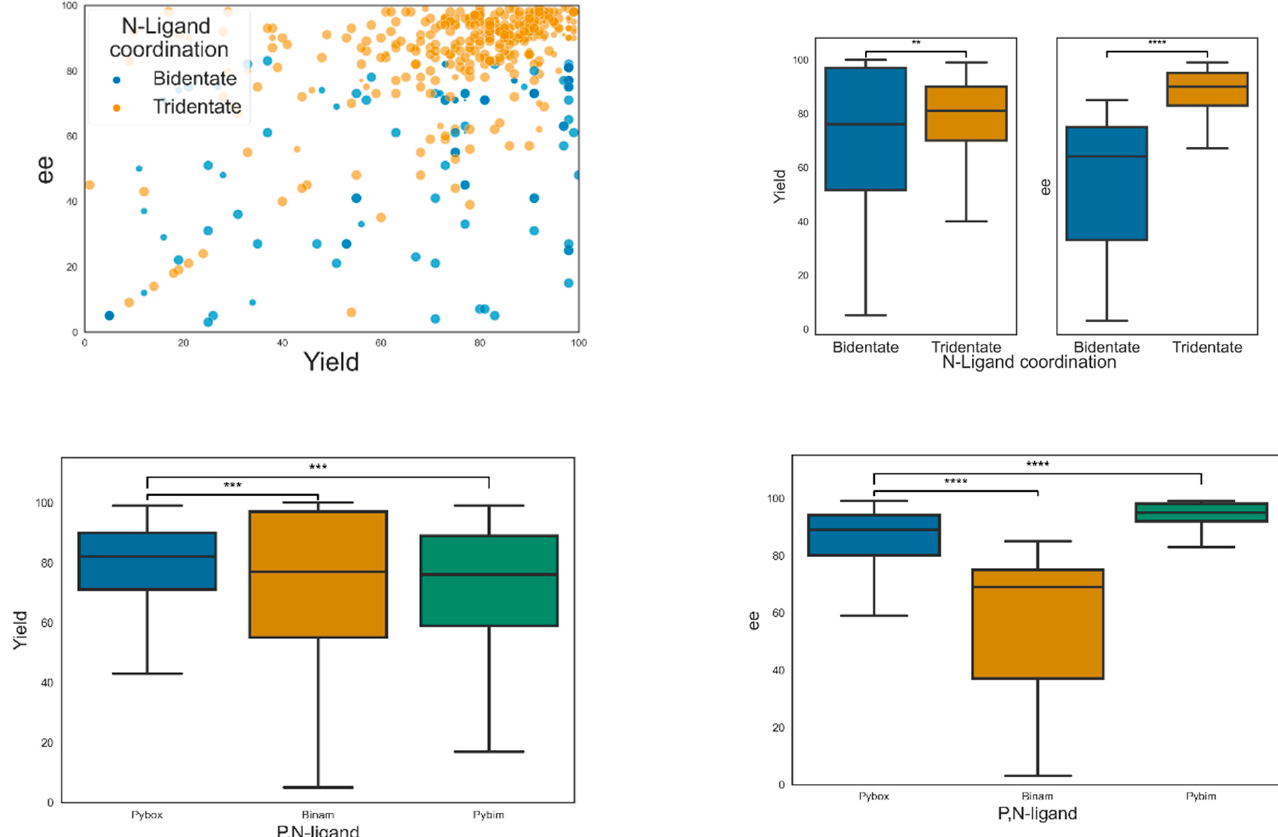
Figure 11. ( upper ) Distribution of N-homoligands by coordination. ( left ) Comparison of yield and ee for N-homoligands. Significance calculated using Student’s t -test ( p = 0.004, 1.74 × 10 − 39 ) ( right ). ( Lower ) Comparison of yield N-homoligands with secondary coordination sphere, the significance was calculated using Student’s t -test ( p = 0.0074, 0.0011) ( left ) Comparison of ee N-homoligands with secondary coordination sphere. Significance calculated using Student’s t -test ( p = 1.55 × 10 − 27 , 0.00015) ( right ). Symbol Meaning: ** p ≤ 0.01, *** p ≤ 0.001, **** p ≤ 0.0001 (For the last two choices only).